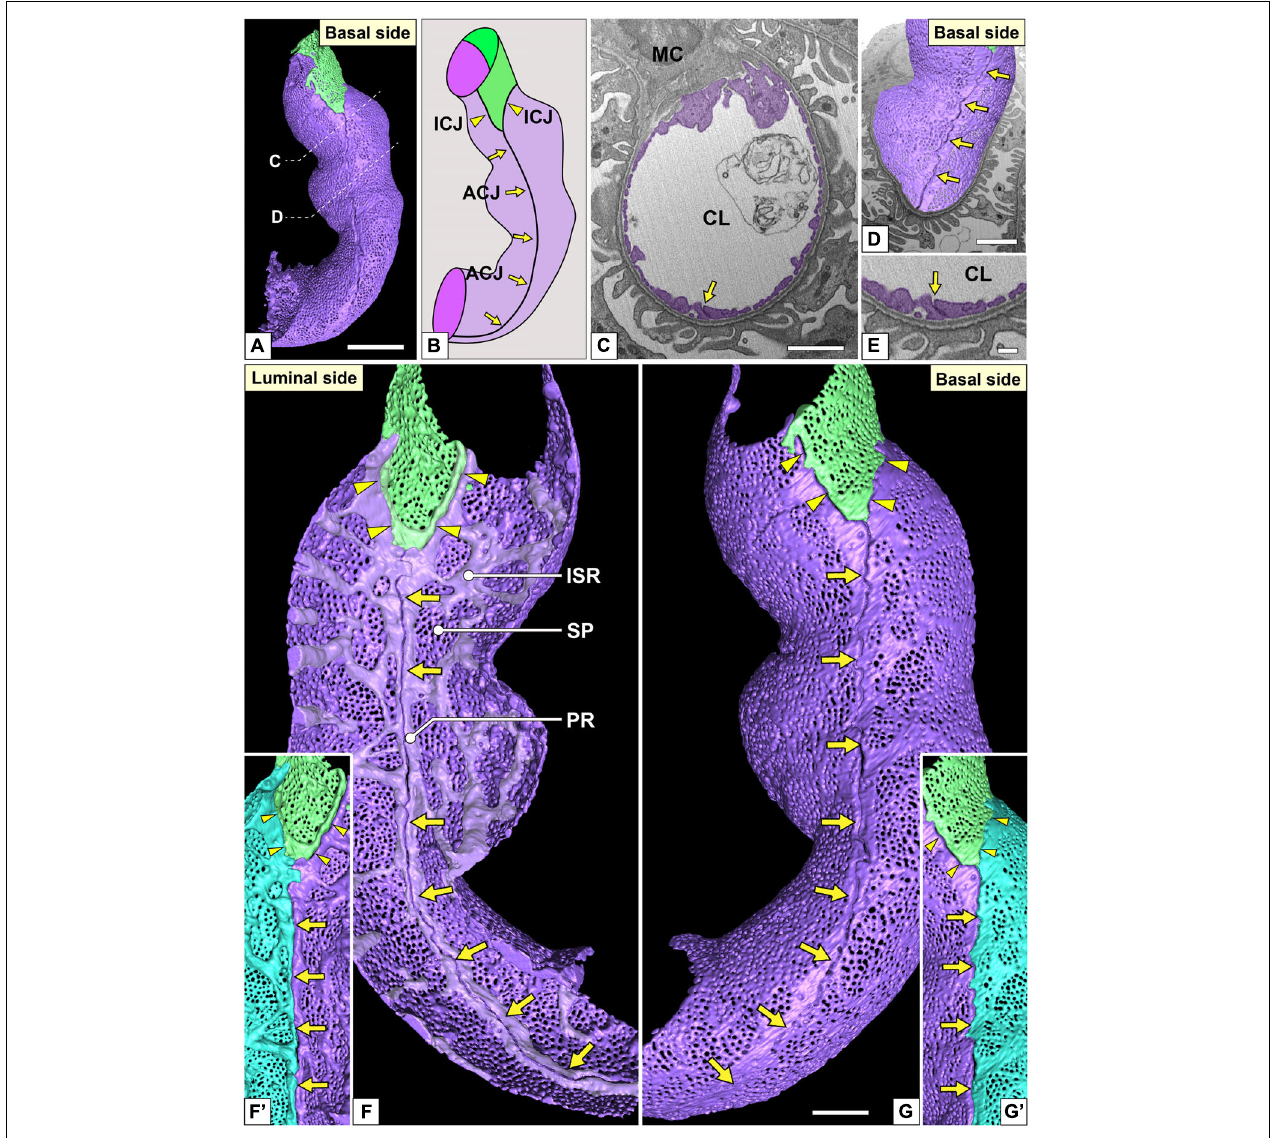
FIGURE 4 | Urinary region and autocellular junction of glomerular endothelial cells (GEnCs). (A) A reconstructed capillary is formed by two GEnCs (purple and green). (B) The location of cellular junctions in this capillary. The purple GEnC forms an autocellular junction (ACJ), which is along the longitudinal axis of the capillary. ICJ, intercellular junction between green and purple GEnCs. (C) The sectional focused-ion beam-scanning electron microscopy (FIB-SEM) image of the purple GEnC. CL, capillary lumen; MC, mesangial cell. (D) The reconstructed GEnCs are displayed on the sectional FIB-SEM image. (E) Magnified image of the ACJ shown in (C) . The luminal (F,F (cid:48) ) and basal (G,G (cid:48) ) surfaces of the urinary region. (F) Two peripheral ridges of the purple GEnC bulge into the capillary lumen and are aligned in parallel to form an ACJ (arrows in F ). Between purple and green GEnCs, an intercellular junction is formed via their peripheral ridges (arrowheads in F ). The peripheral and intersieve ridges were represented by whitish-purple. (G) The basal surface of these cytoplasmic ridges is smooth. (F (cid:48) ,G (cid:48) ) To show the location of the ACJ more clearly, a part of the purple GEnC is displayed on the right in blue. Arrows, ACJ; arrowheads, ICJ. ISR, intersieve ridge; PR, peripheral ridge; SP, sieve plate. Scale bar, 5 µ m in (A,C,D) ; 2 µ m in (G) ; and 100 nm in (E) . The reconstructed image of GEnCs (F,G) is also shown in Supplementary Movie 4